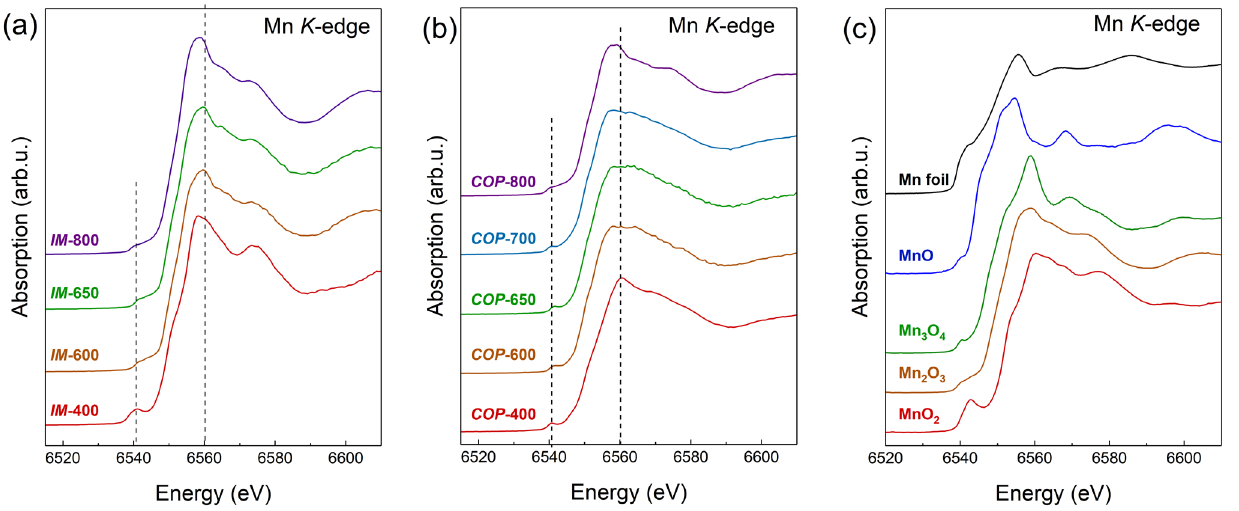
Figure 5. XANES spectra of the IMP ( a ) and COP ( b ) catalysts, and those of standard manganese compounds ( c ).